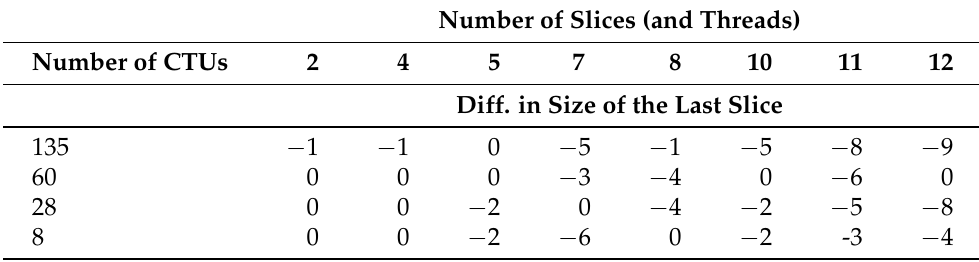
Table 6. Difference in size of the last slice (in